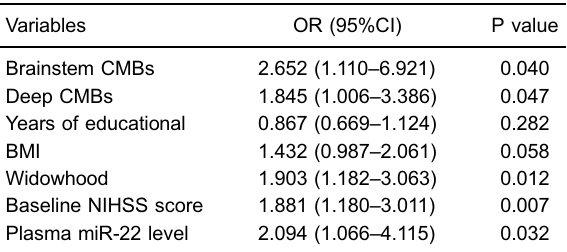
Table 4. Multivariate logistic model of the clinical determinants of post-stroke